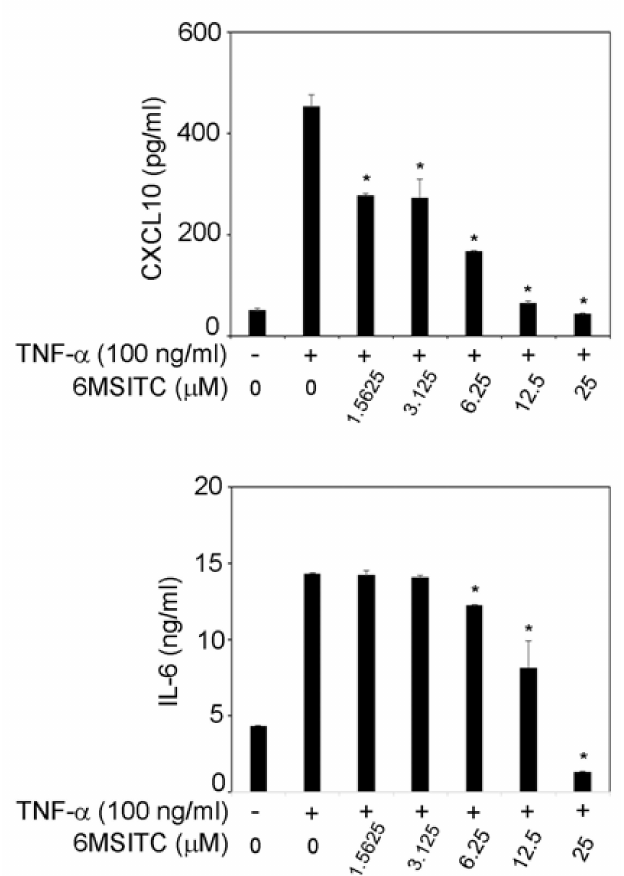
Figure 2. Effects of 6-MSITC on TNF- α -induced production of CXCL10 and IL-6. Sub-confluent TR146 cells were cultured with TNF- α (100 ng/mL) with or without 6-MSITC (1.5625–25 µ M) for 24 h. The amounts of CXCL10 and IL-6 in the supernatant were determined using their respective ELISA kits as described in the Materials and Methods section. Data are expressed as the mean ± SD of 3 independent experiments. * = p < 0.05, significantly different from the TR146 cells stimulated with TNF- α without 6-MSITC.